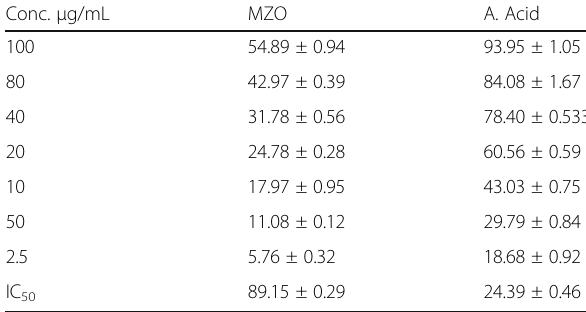
Table 4 FRAP activity of leaf extract of methanol extract of Zingiber officinale